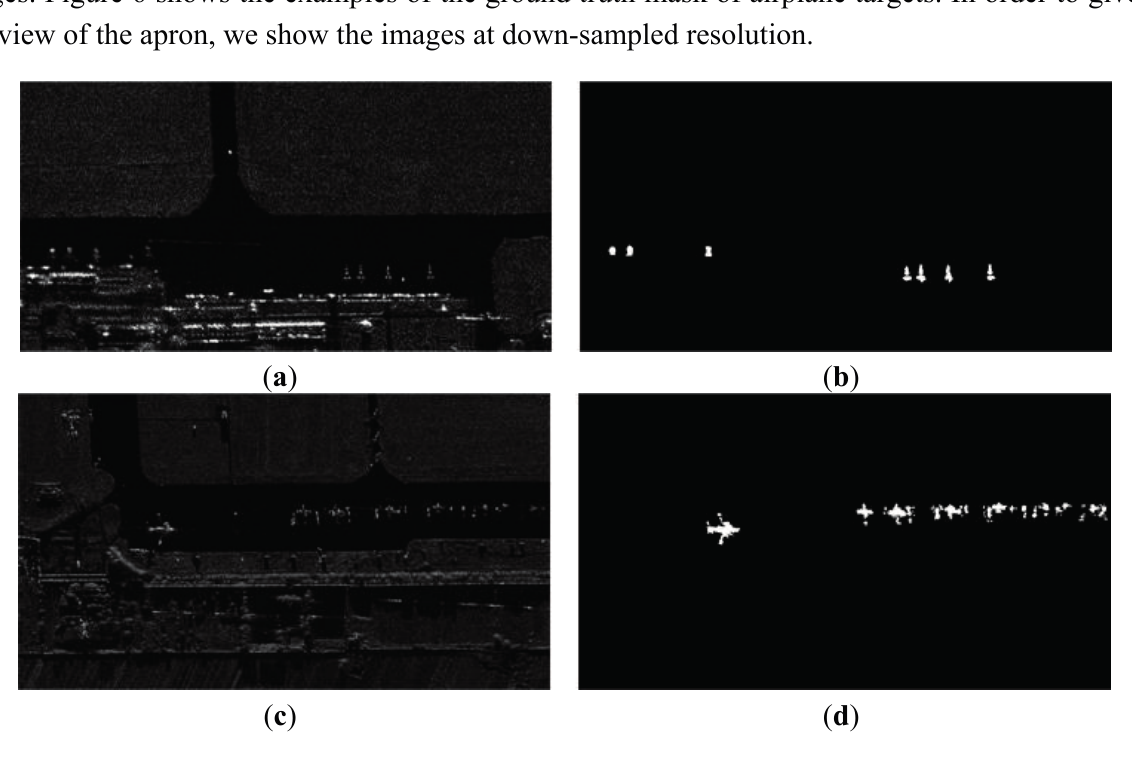
Figure 6. The ground truth examples of airplane targets in SAR images. ( a , c ) are the original SAR images; ( b , d ) are the ground truth targets labeled by